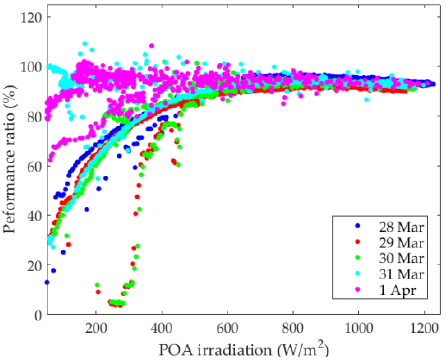
Figure 3. Temperature-corrected PR as a function of POA irradiation